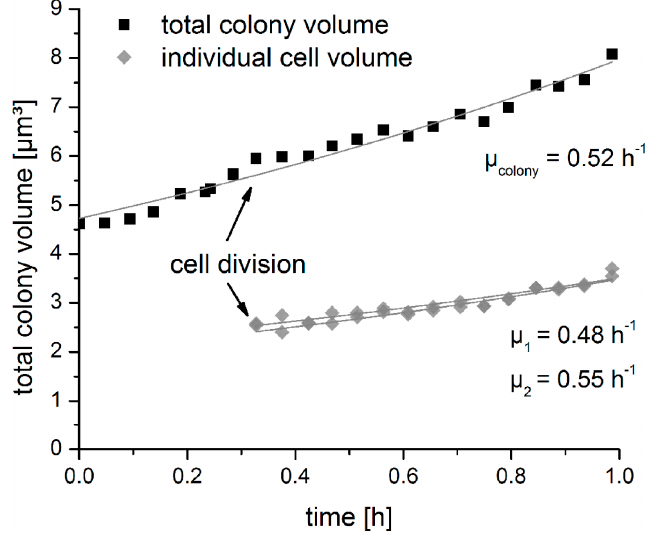
Figure 7. Volume growth of an initial single cell ( C. glutamicum DM1730 pSenLys), trapped with nDEP in the inert LOC device. A cell was isolated, trapped and cultivated for 1 h. After 20 min the cell divided. Total colony volume and individual cell volumes were measured over time and exponentially fitted.